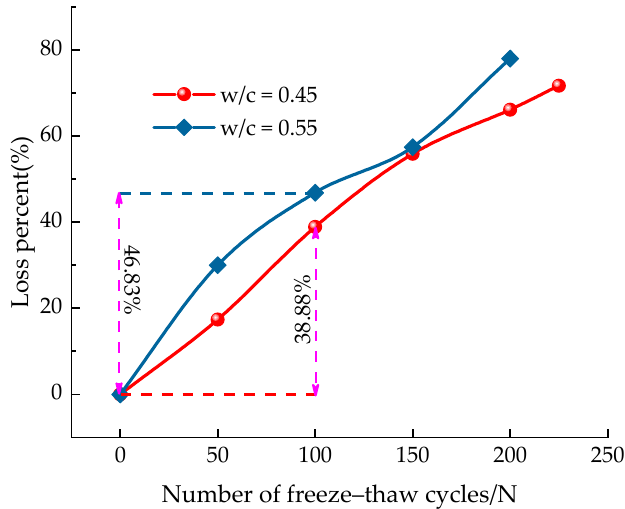
Figure 15. Variation of the loss rate of f f of concrete specimens with different water–cement ratios under freeze–thaw cycles.